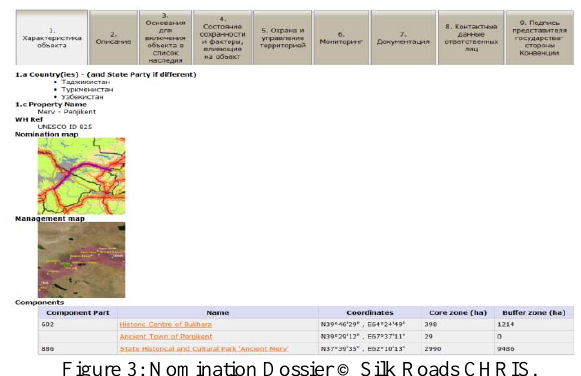
Figure 3: Nomination Dossier © Silk Roads CHRIS.